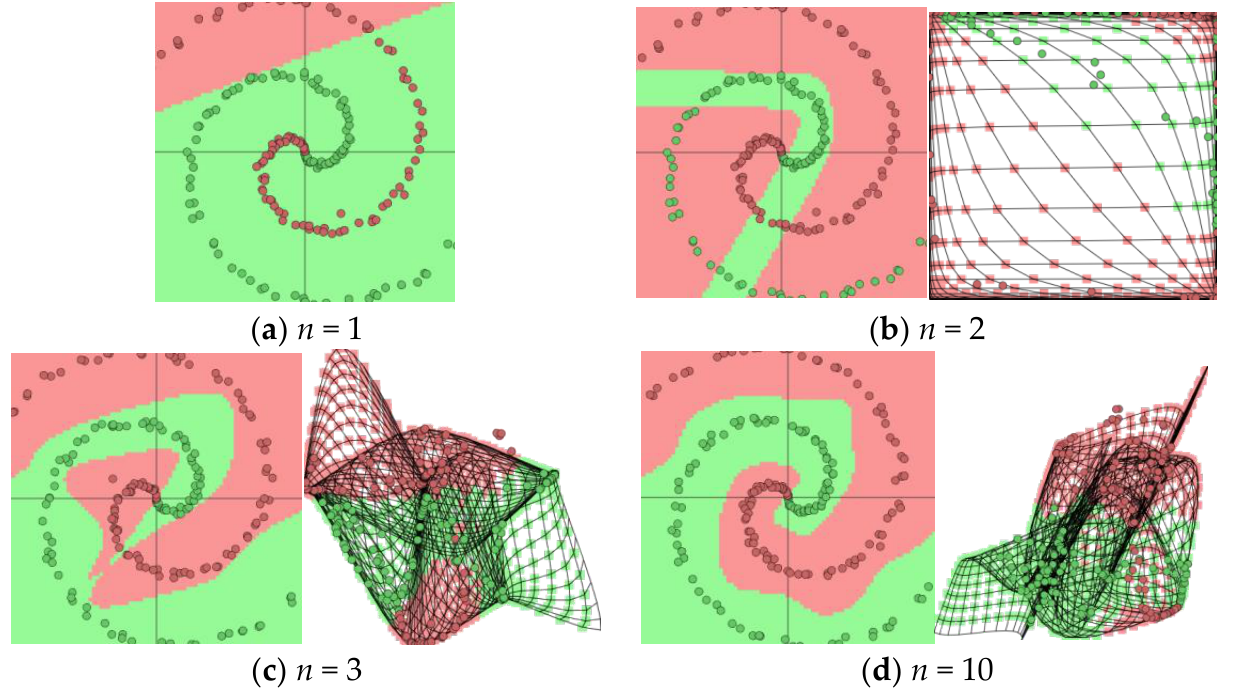
Figure 8. The effect of the number of neurons on the neural network. In order to verify the influence of the neural network on the microgrid, the number of neurons n = 4 was selected to predict the load of grid. Power load projections were made using city electricity data from 1 January 2018 to 31 December 2018 for a city. The first 361 data points were used as the training model for data input, and the last four data points were used as the test model to obtain the final experimental results compared with the real data of the original power load. Changes in data projections are shown in Figure